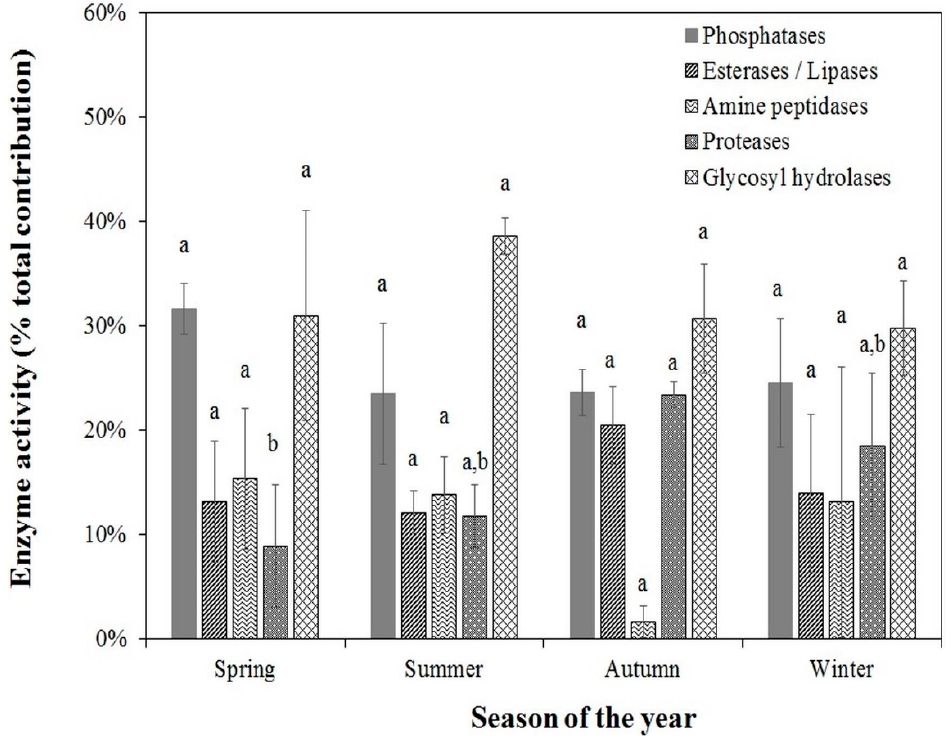
Figure 5. Contribution of extracellular enzyme activity separated into families for biosolids obtained at different times of the year. The bar represents the standard deviation of 3 replicates. Different letters on each column represent significant difference for that family of enzymes between seasons of the year.